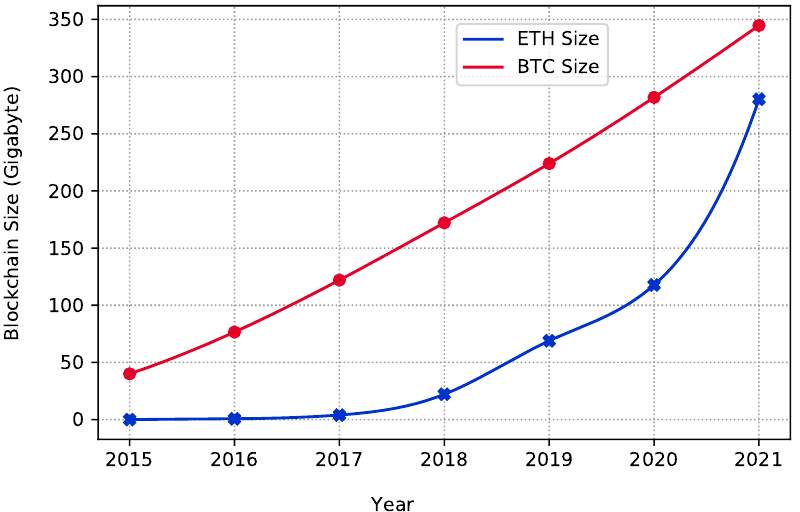
Figure 7. Storage capacity comparison between BTC and ETH technology using data from the Blockchain, Etherscan, and Statista